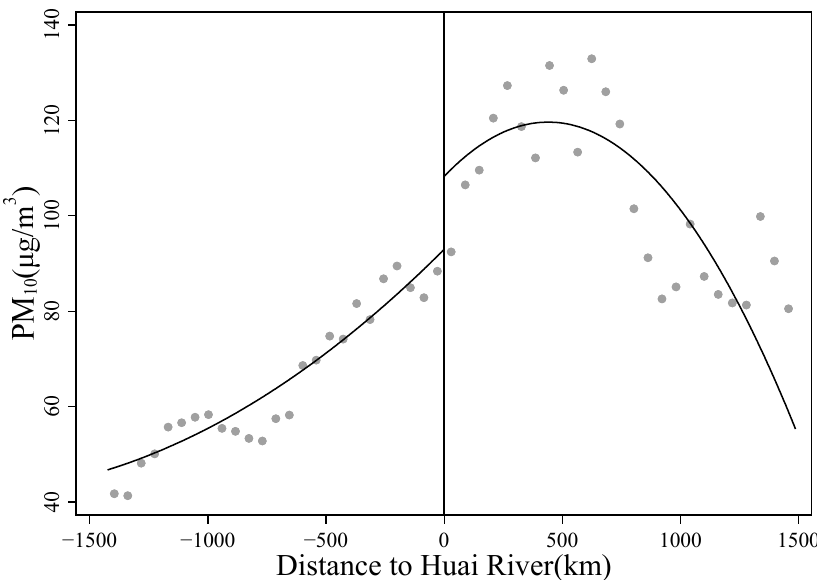
Figure 2. RD plot for PM 10 . Note: The figure plots the binned averages of county-level PM 10 concentrations against the running variable. The solid line represents a quartic polynomial fit of PM 10 on each side of the threshold.